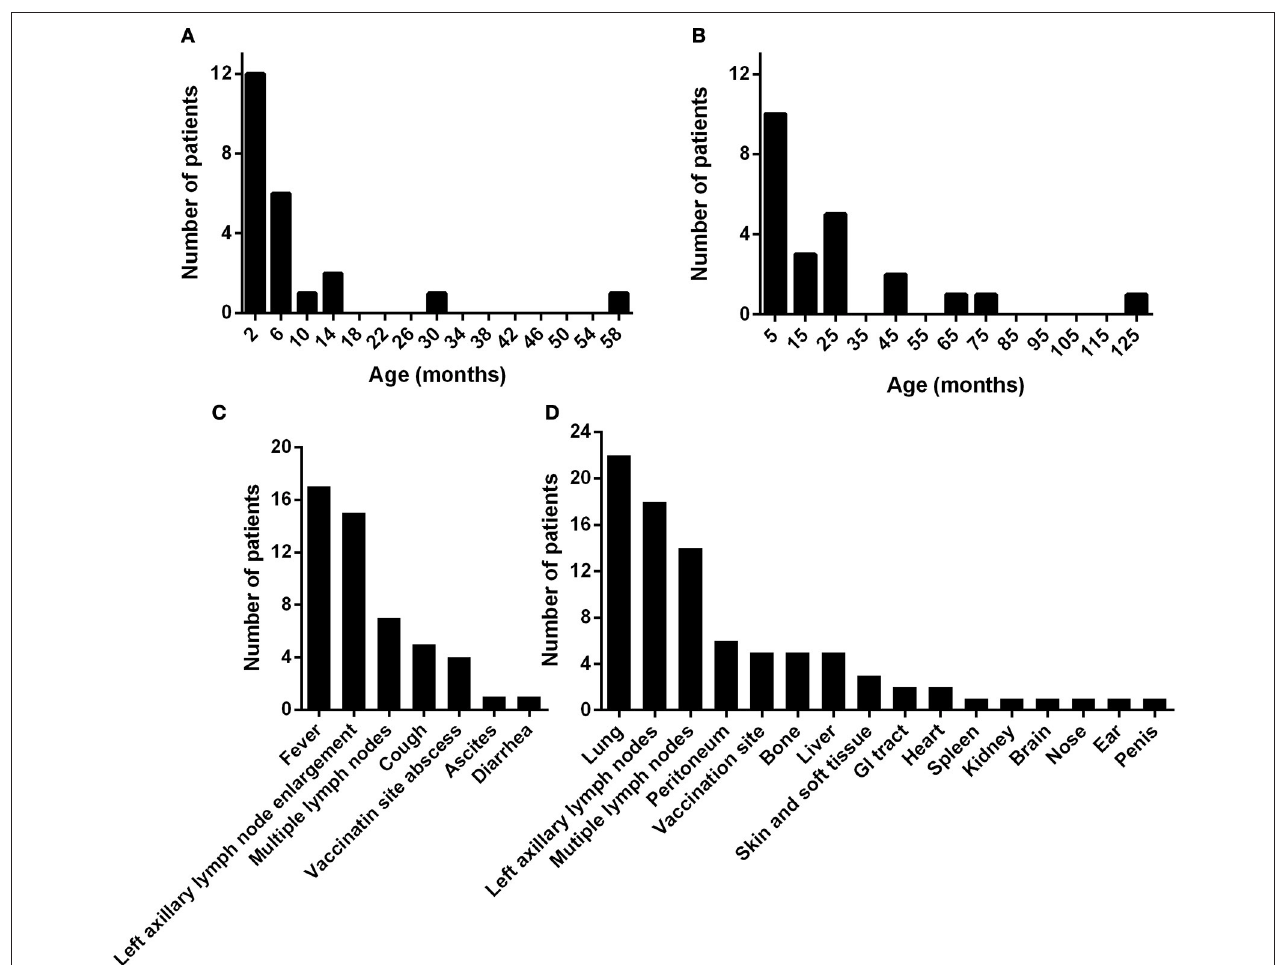
FIGURE 1 | The ages at symptom onset (A) and at the diagnosis of disseminated Bacillus Calmette-Guérin disease (B) in 23 patients with CGD. The (C) initial symptoms, and (D) dissemination sites of Bacillus Calmette-Guérin disease. GI,